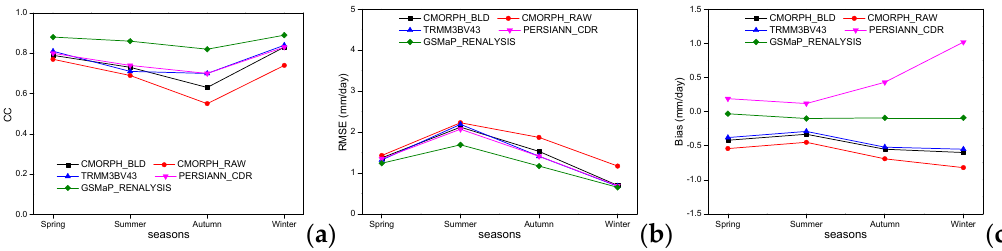
Figure 5. ( a – c ) denote the CC, BIAS and RMSE values of the satellite products and rain gauge stations for the seasonal daily mean precipitation values, respectively.